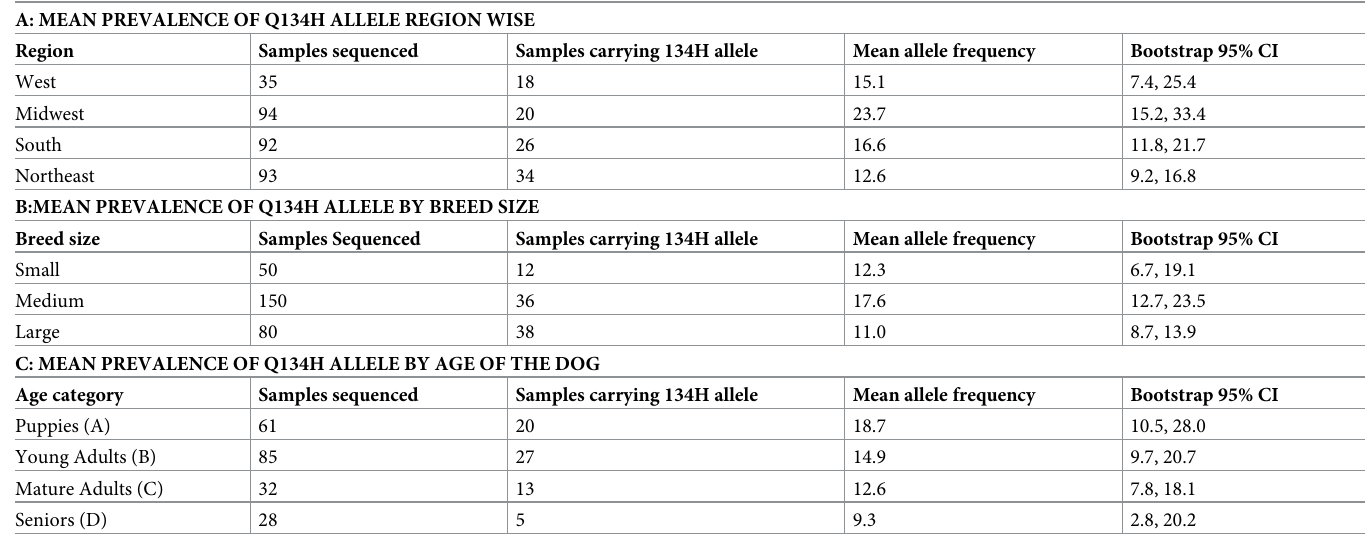
Table 2. Prevalence of the Q134H(CAA > CAT)